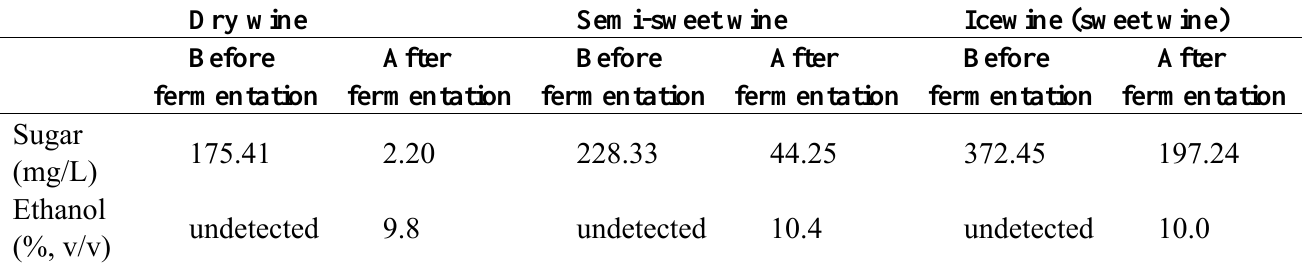
Table 1. Mean values of parameters for wines before and after fermentation.